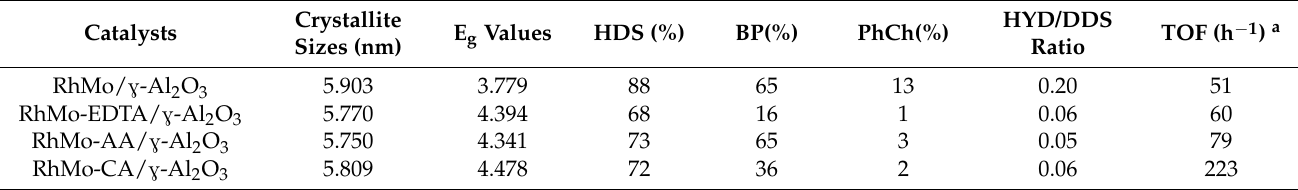
Table 5. Catalytic performances of RhMo/ G -Al 2 O 3 and RhMo-x/ G -Al 2 O 3 (x = EDTA, AA, CA) in hydrotreating of DBT as simulated